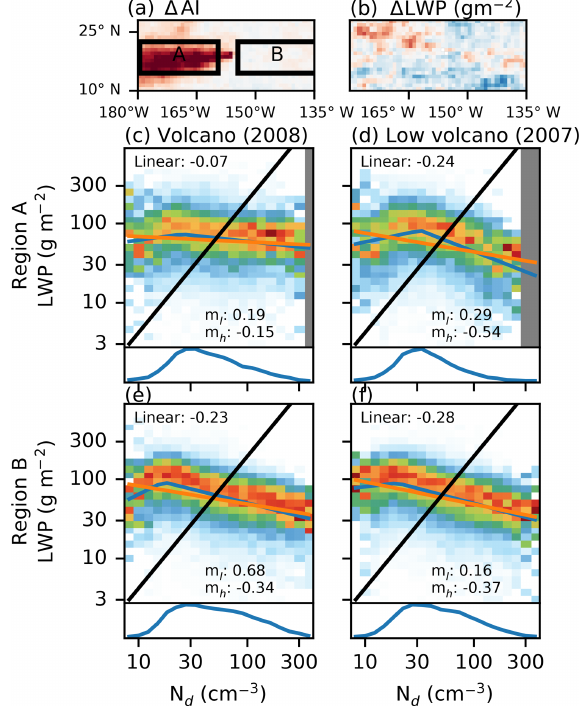
Figure 5. N d –LWP relationships as in Fig. 2 in two regions around Hawai’i for 2 years, a low-emissions year (2007) and a high- emissions year (2008). Panels (a) and (b) show the difference in AI and LWP between the high and low emission years, with red in- dicating an increase in 2008. Panels (c) – (f) show the N d –LWP joint histograms (as in Fig. 2) for the two periods in the regions from (a) .